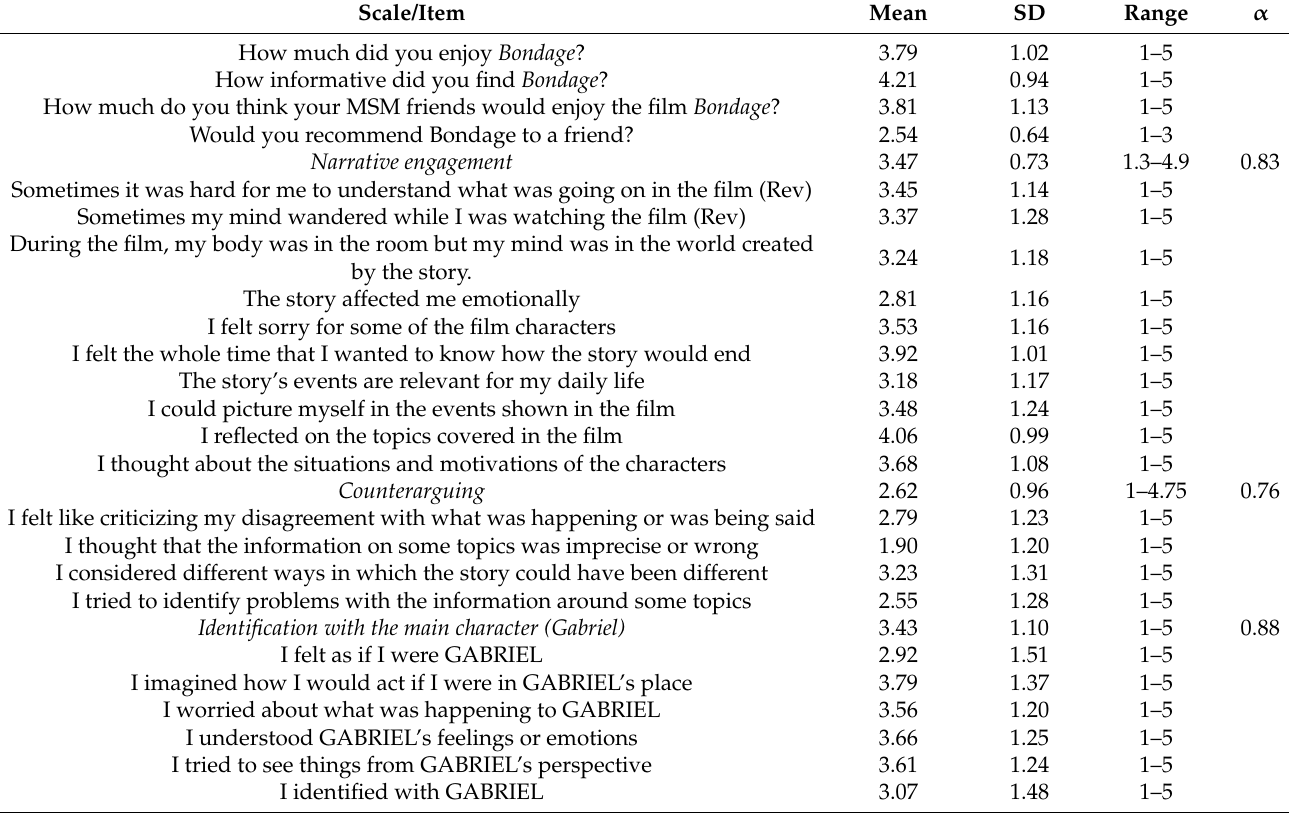
Table 3. Acceptability of the education-entertainment intervention—Measures and Results (Post-viewing survey only; n = 63).